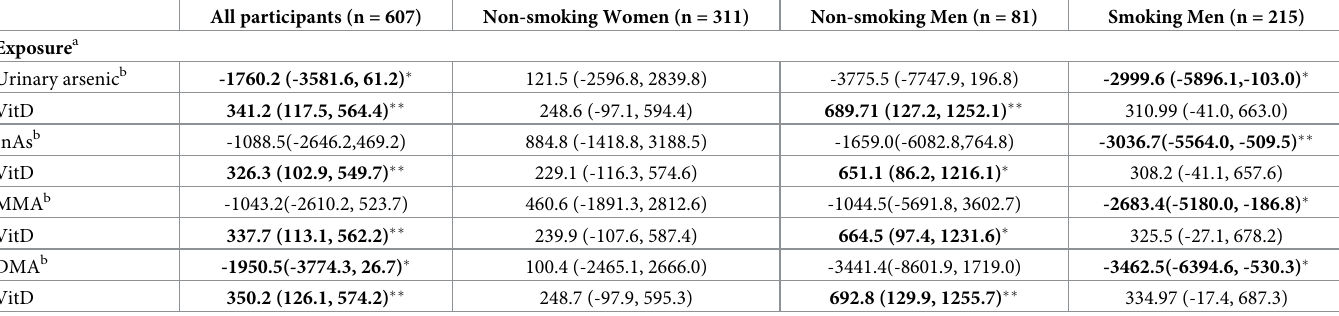
Table 3. Estimated coefficients of arsenic exposure and Vitamin D (VitD) in linear models for CD3-CD28 stimulated T-cell proliferation. All participants (n =